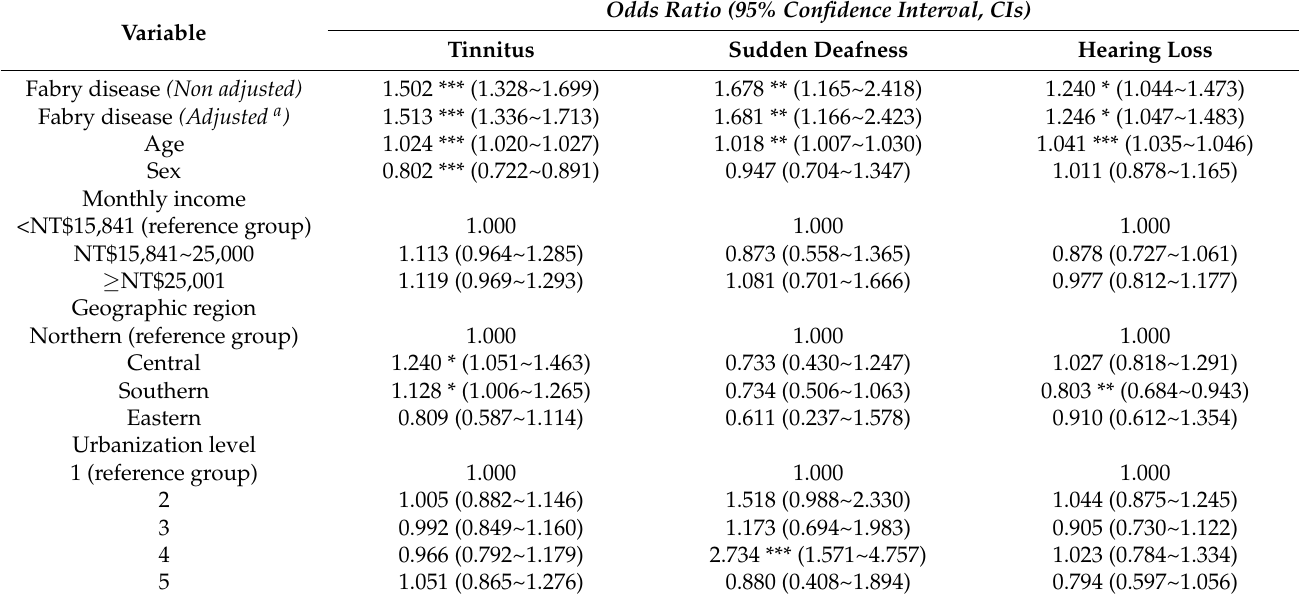
Table 3. Covariate-adjusted odds of tinnitus, hearing loss, and sudden deafness among Fabry disease vs. controls ( n =